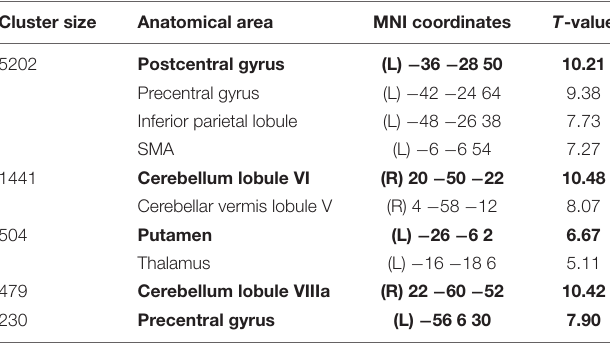
TABLE 1 | Cerebral regions showing significant activity in both FL and SL ( p < 0.05, FWE corrected at cluster-level -voxel defining threshold p = 0.001). Cluster size